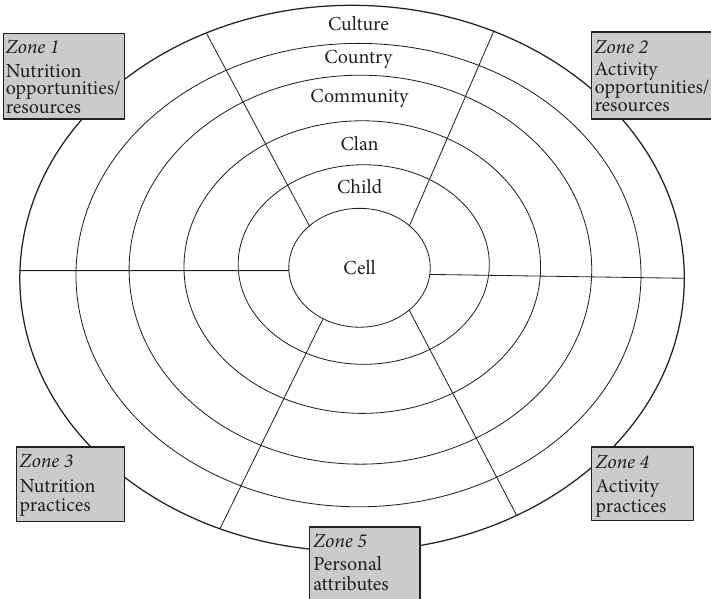
Figure 1: The Six C’s Ecological Developmental Model of contributors to overweight and obesity in childhood